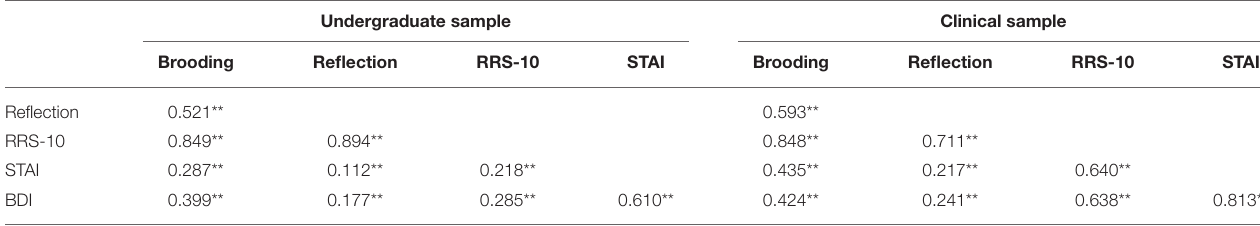
TABLE 2 | Correlations among STAI, BDI, and RRS-10